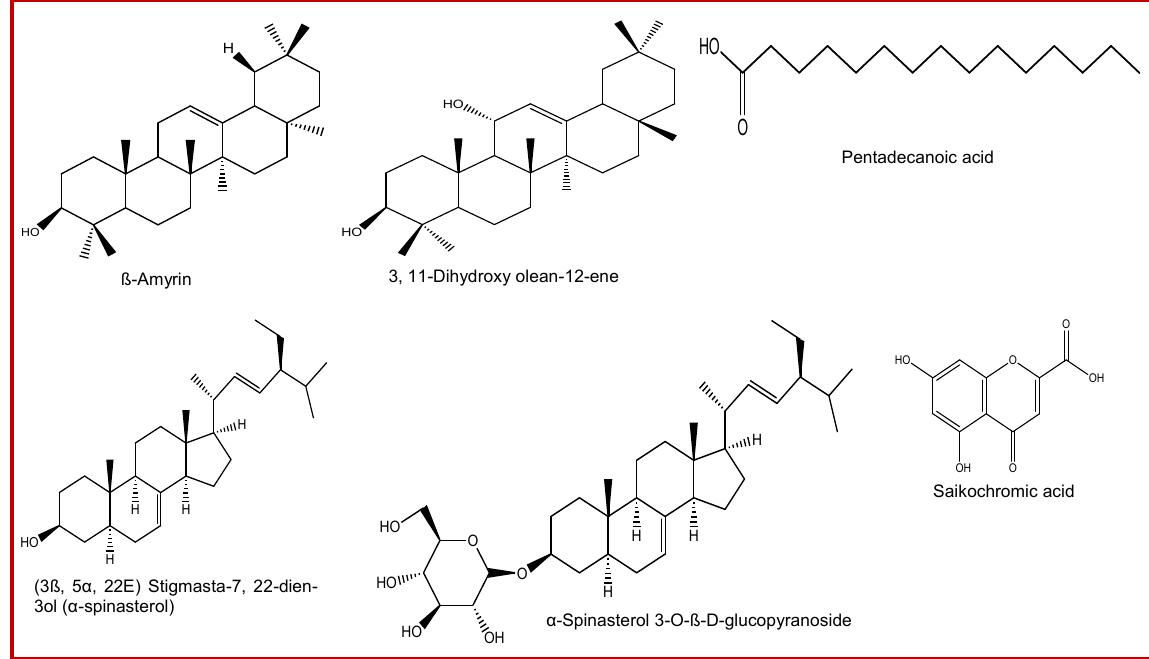
Figure 1: Structures of compounds isolated from Physospermum